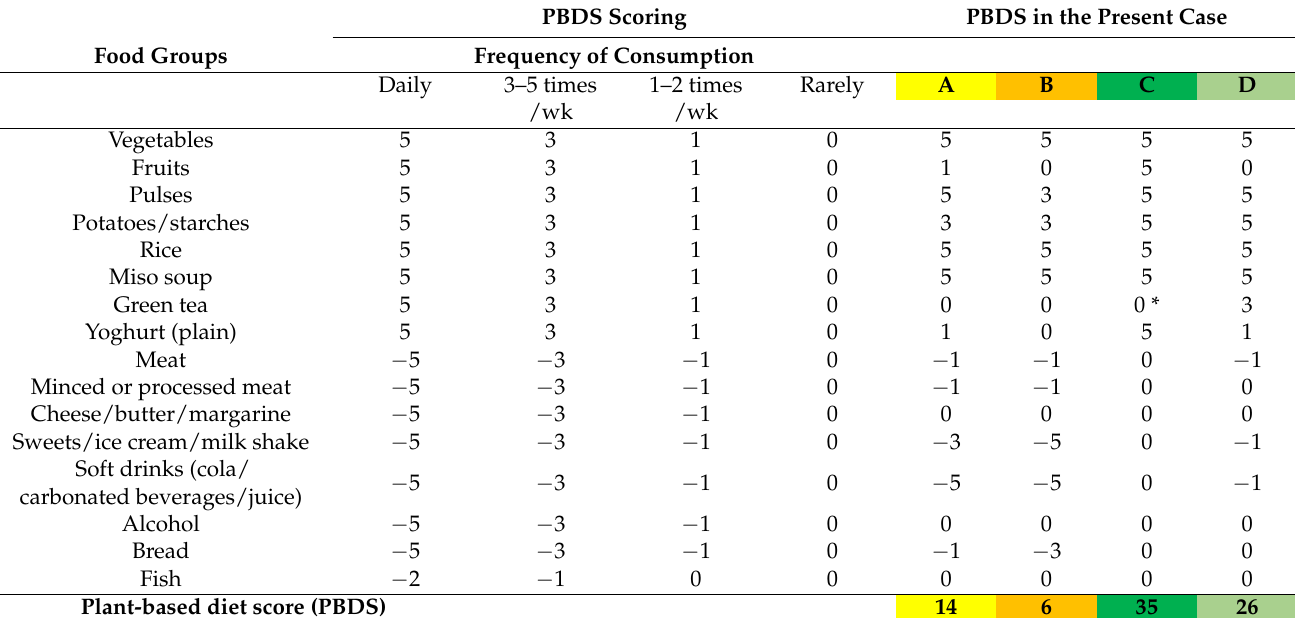
Table 4. Chronological change of plant-based diet score